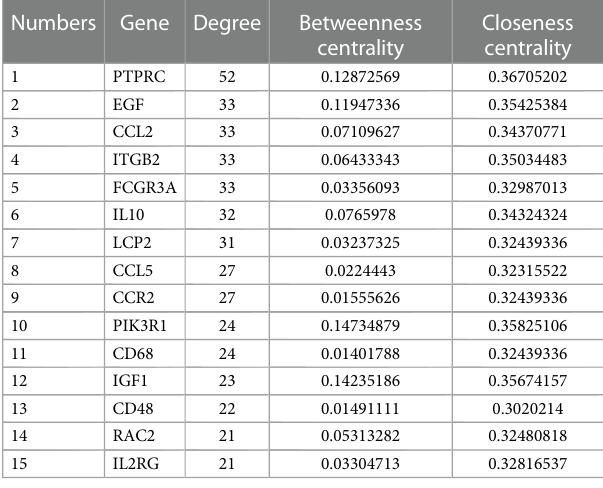
TABLE 1 Topological parameters of core genes in the PPI